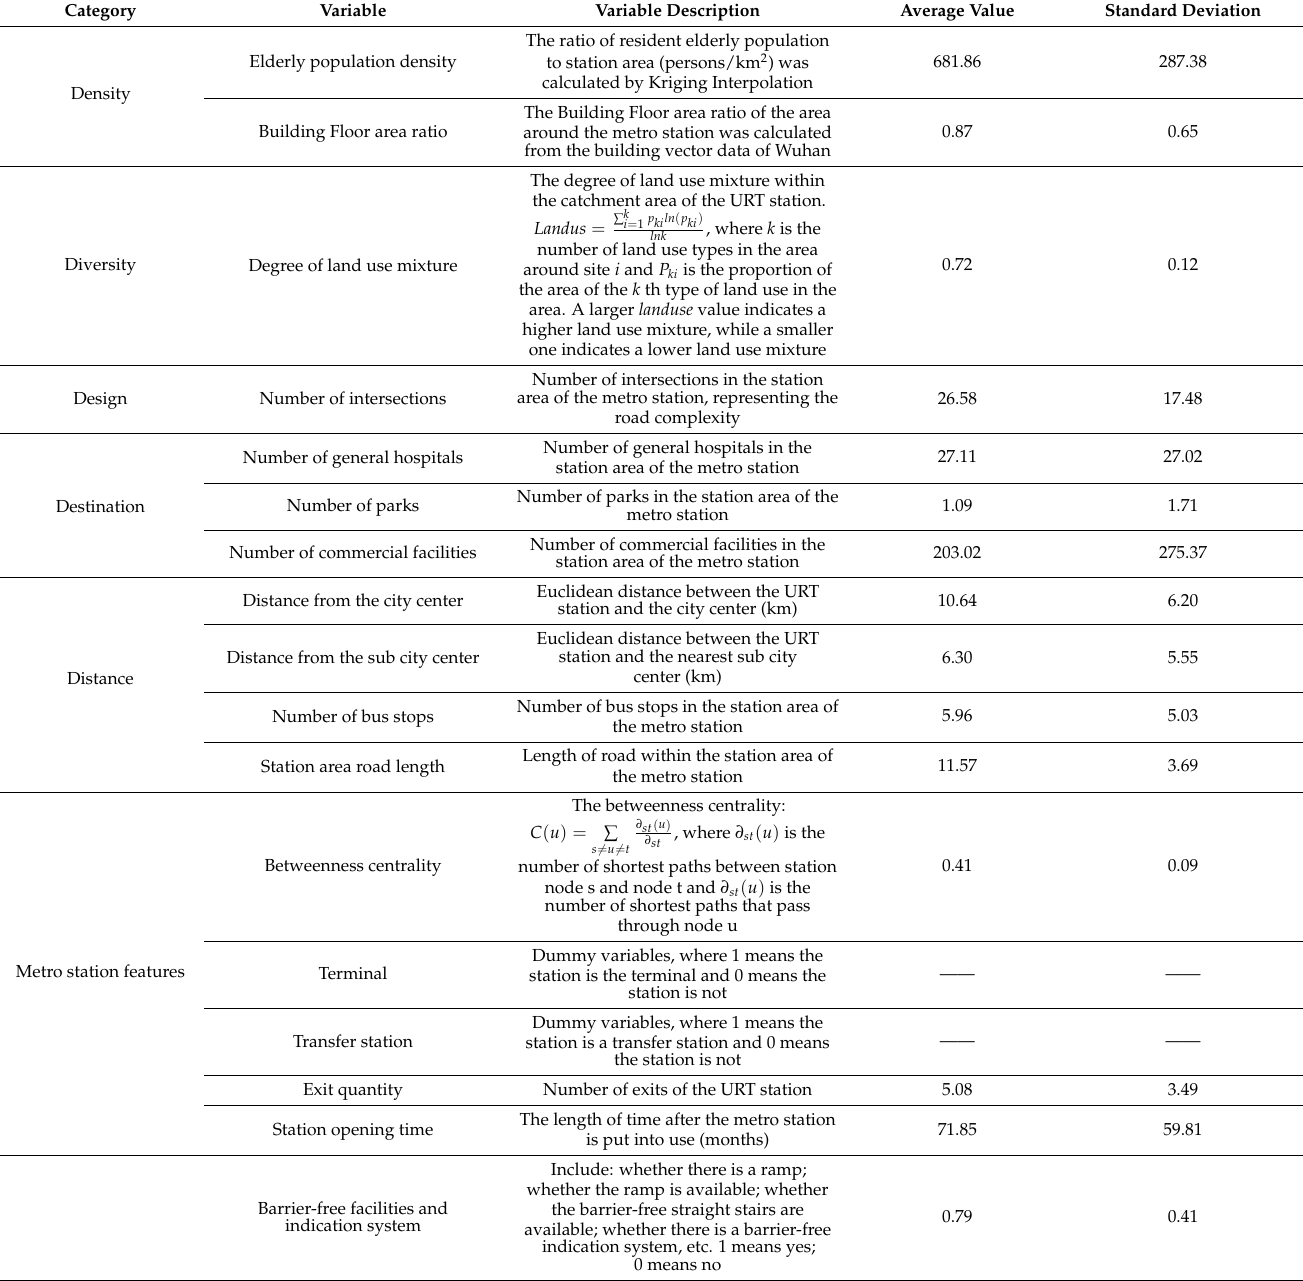
Table 1. Description of the